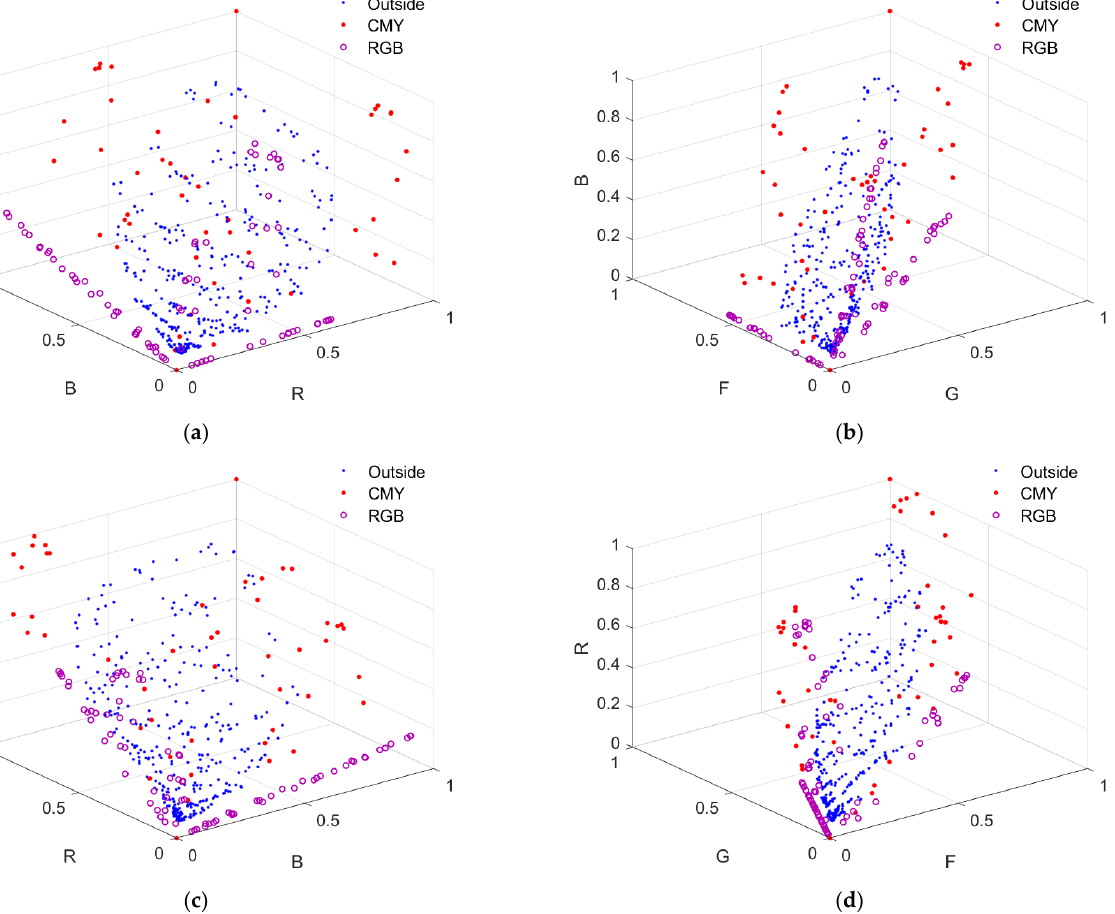
Figure 7. Color points of ARSs created with CYM and RGB filters shown as 47 red dots and 79 purple hollow dots, respectively, in the ( a ) RGB, ( b ) GBF, ( c ) BFR and ( d ) FRG signal spaces using the RGBF camera. The 340 outside samples are shown as blue dots for comparison.